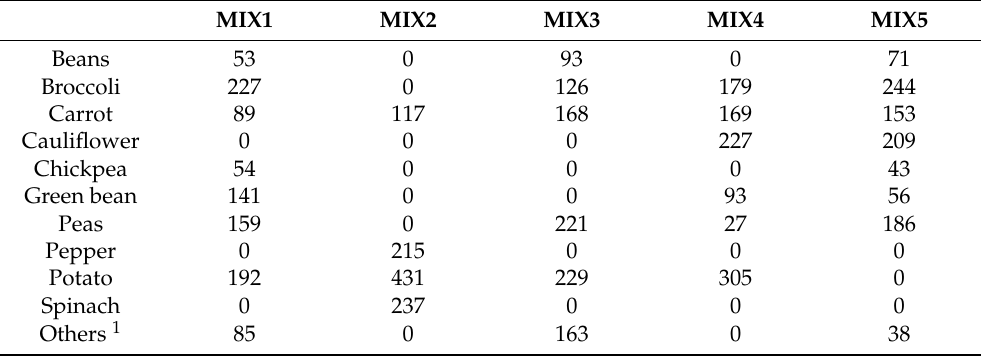
Table 1. Individual composition of vegetable by-product in 5 mixes (g/kg of fresh matter) mimicking the real by-product generation of the frozen agri-food industry in